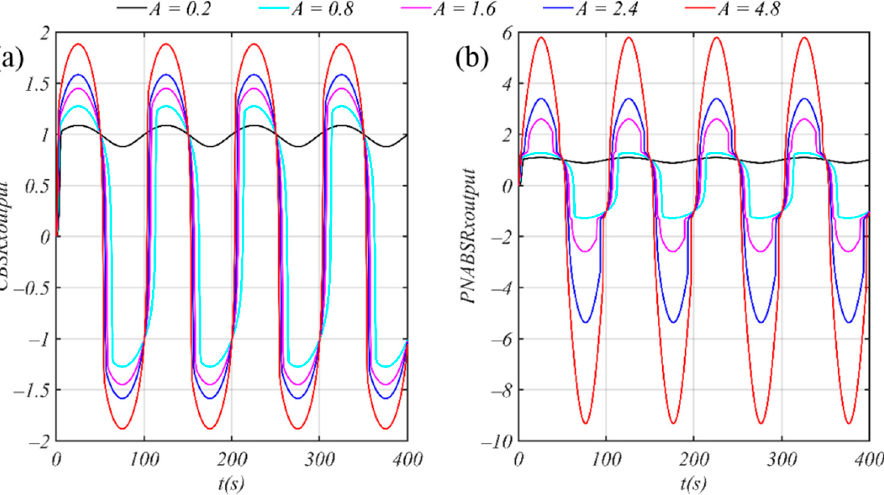
Figure 3. Comparison of output signals of CBSR and PNABSR models: ( a ) CBSR; ( b ) PNABSR. ( D = 0, f = 0.01 Hz, f = 10 Hz. ) 0 s